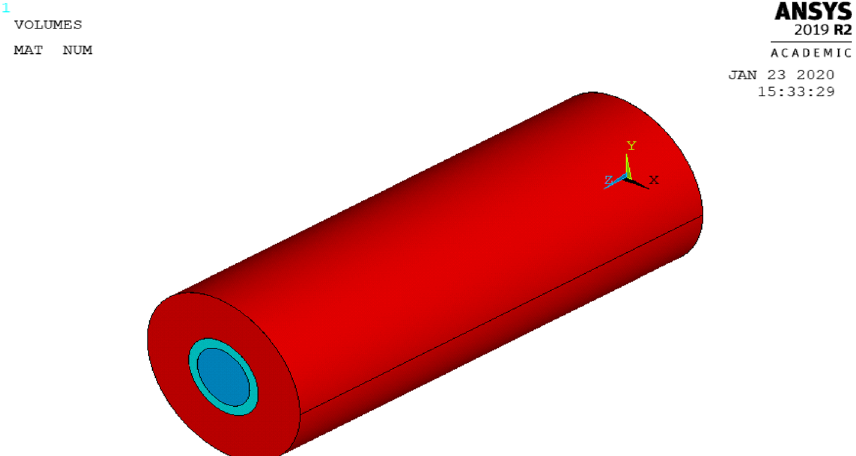
Fig. 12 Finite element model of grouted coupler and cover